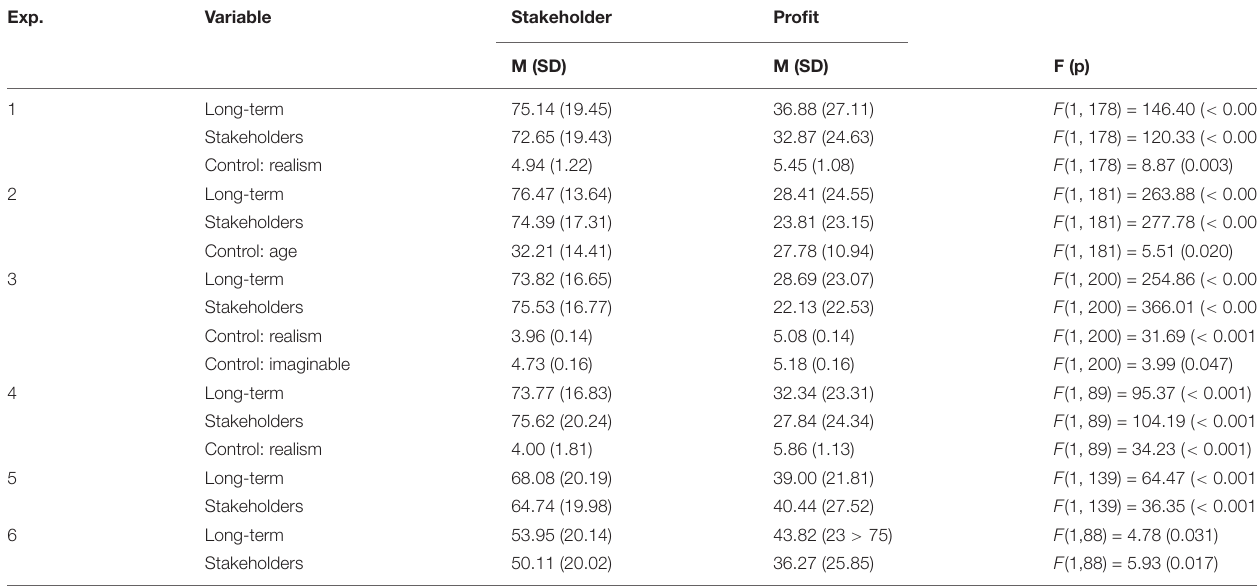
TABLE 1 | Means, standard deviations, and significance levels of manipulation checks and control variables in experiments 1–6.